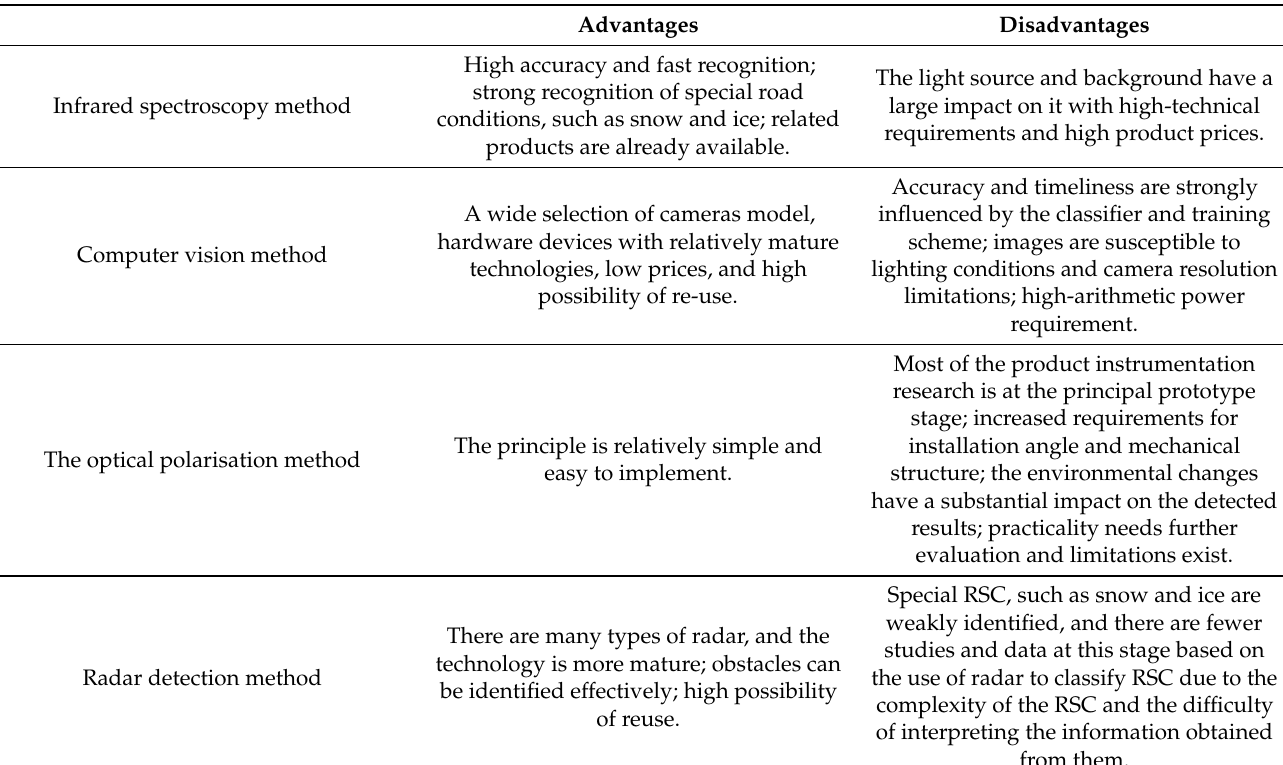
Table 6. Comparison of four RSC detection